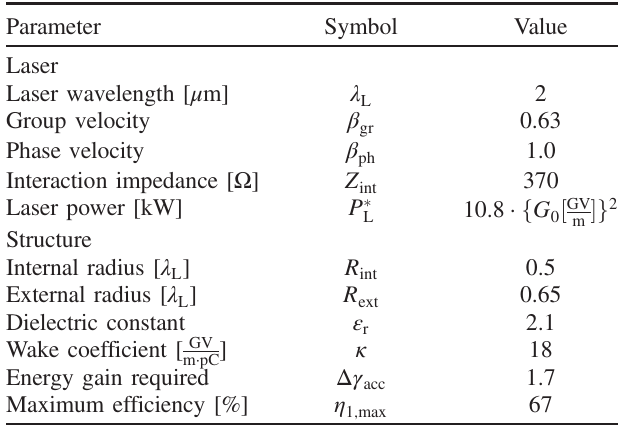
TABLE I. Parameters of the laser and the envisaged structure shown in Fig. 1. (*) Average laser power formula is given by P